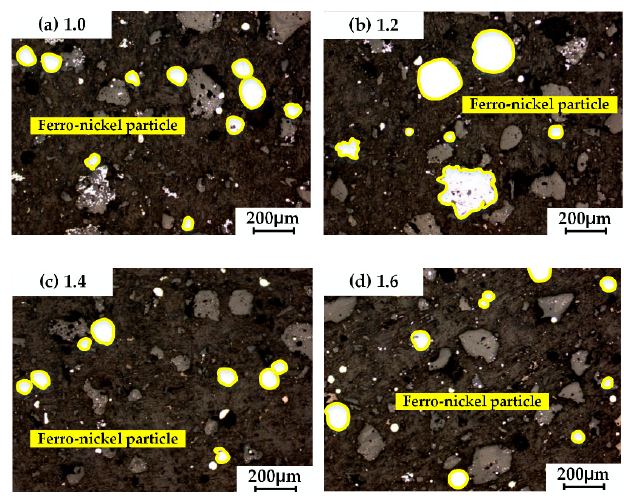
Figure 10. Optical microscope images of ferro-nickel particles under different carbon ratios: ( a ) 1.0;